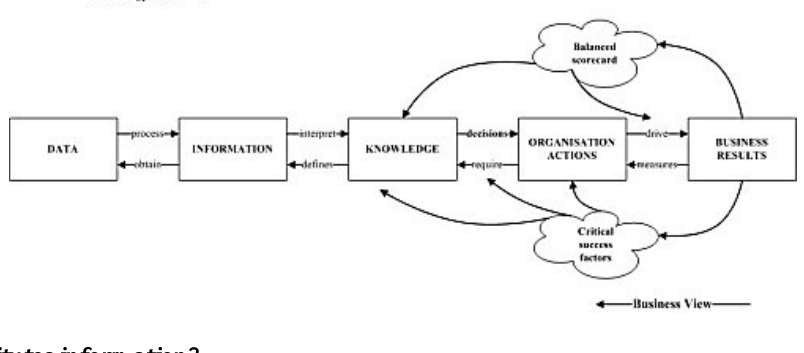
Table 1 Exclusionary narrowing of the term 'information' by Machlup and Mansfield (Bovee 2004:11) To be 'information' something